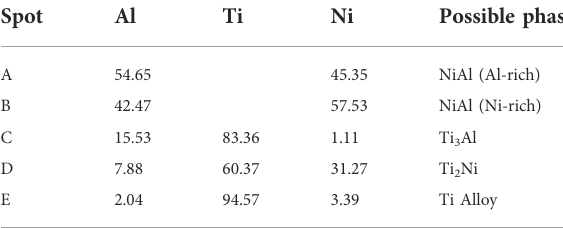
TABLE 2 Chemical composition (in at%) of the phases in Figure